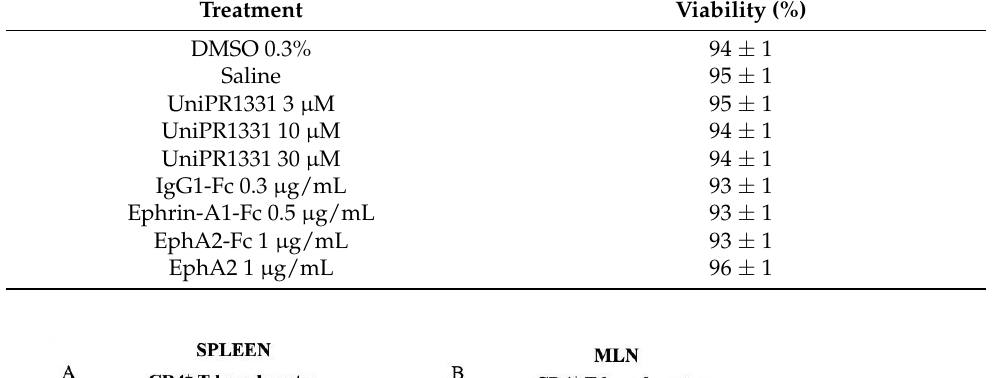
Table 1. Effects of UniPR1331 and recombinant proteins on the viability of splenic lymphocytes. Percent viability of cultured lymphocytes, assessed through propidium iodide exclusion assay, after incubation with DMSO 0.3% (vehicle for UniPR1331), saline solution (vehicle for recombinant proteins), UniPR1331 (3–30 µ M), IgG1-Fc 0.3 µ g/mL, ephrin-A1-Fc 0.5 µ g/mL, EphA2-Fc 1 µ g/mL and EphA2 1 µ g/mL in the presence of PMA and ionomycin. Data are expressed as the mean value ± SEM ( n = 3–4 independent values).